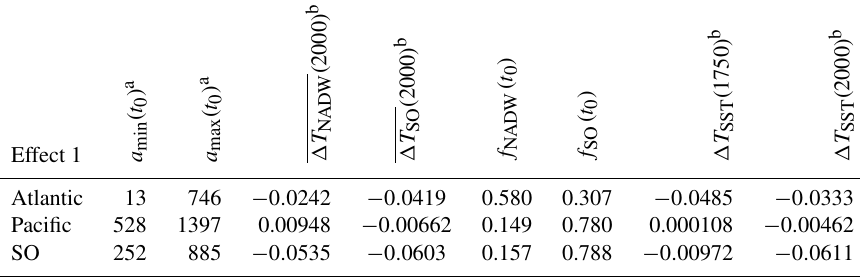
Table B2. Computing effect 2a, changing water masses. The first six columns containing data present a subset of the diagnosed values needed for the computation: as an example, only water masses NADW and SO are shown. In addition, f i ( t 0 ) from Table B1 are used. The two rightmost columns show the result of effect 2a by using Eq. (B2), where all eight water masses were taken into account.